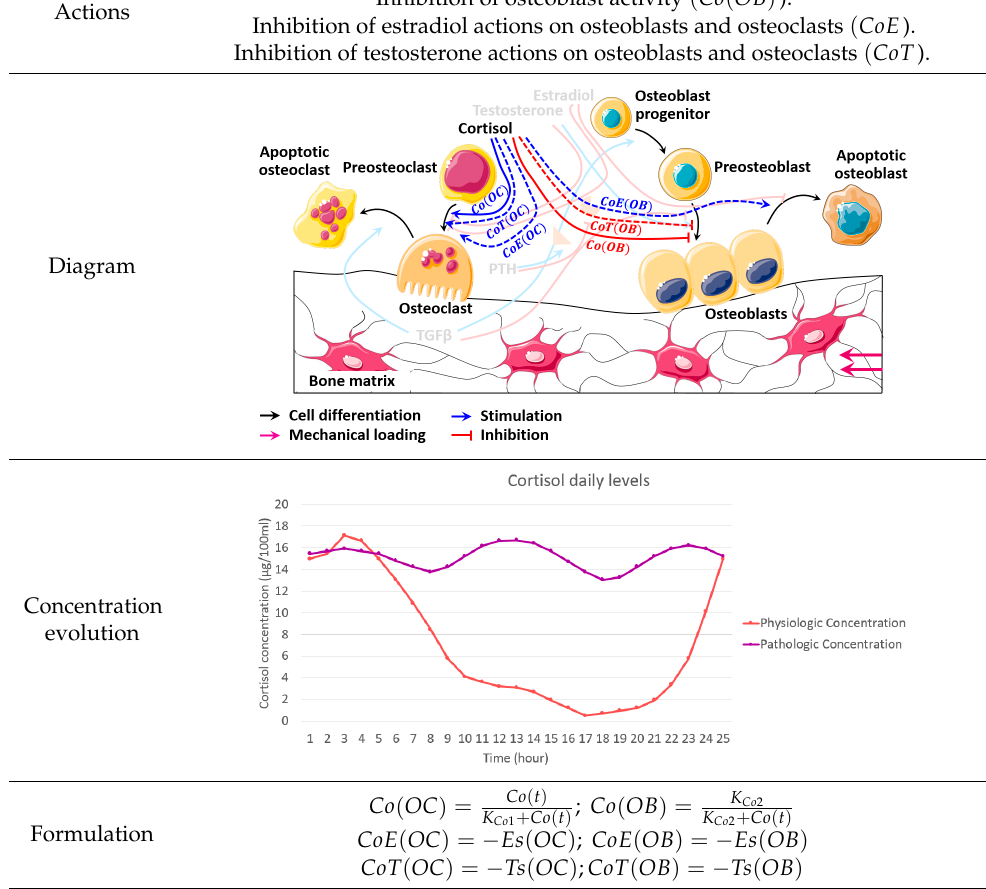
Table 5. Cortisol actions and their mathematical formulation.